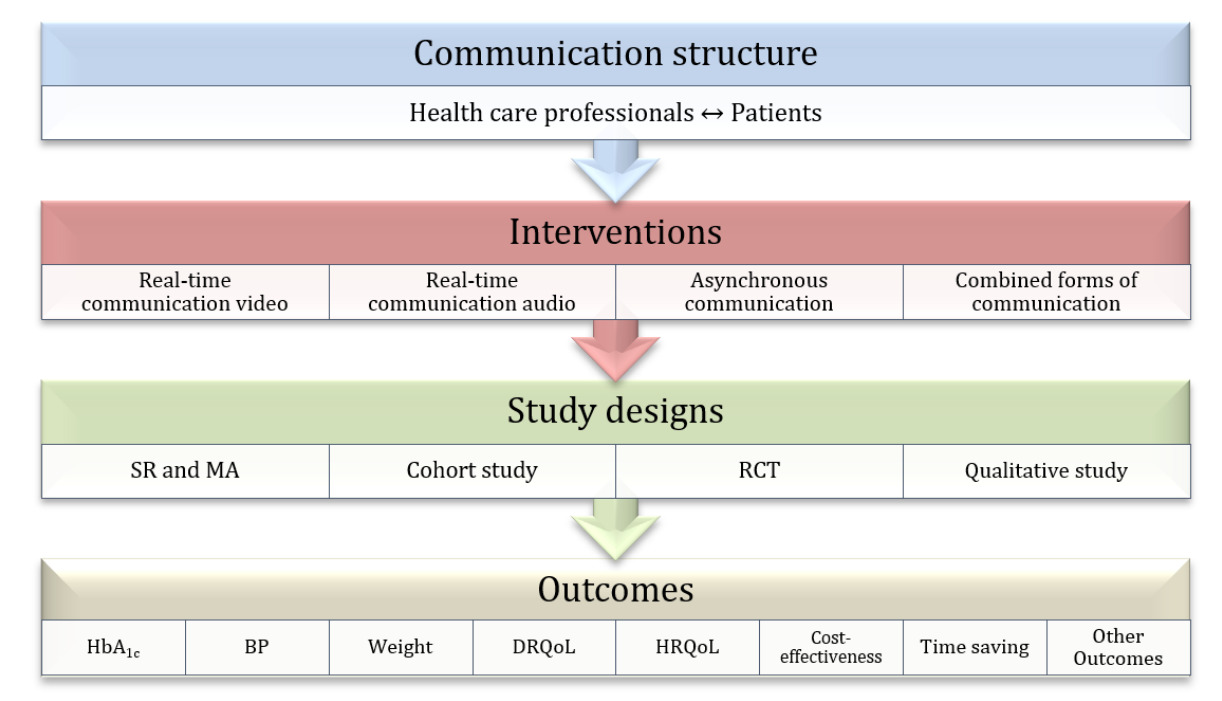
Figure 2. Scheme for structuring the included studies. BP: blood pressure; HbA 1c : hemoglobin A 1c ; DRQoL: diabetes-related quality of life;